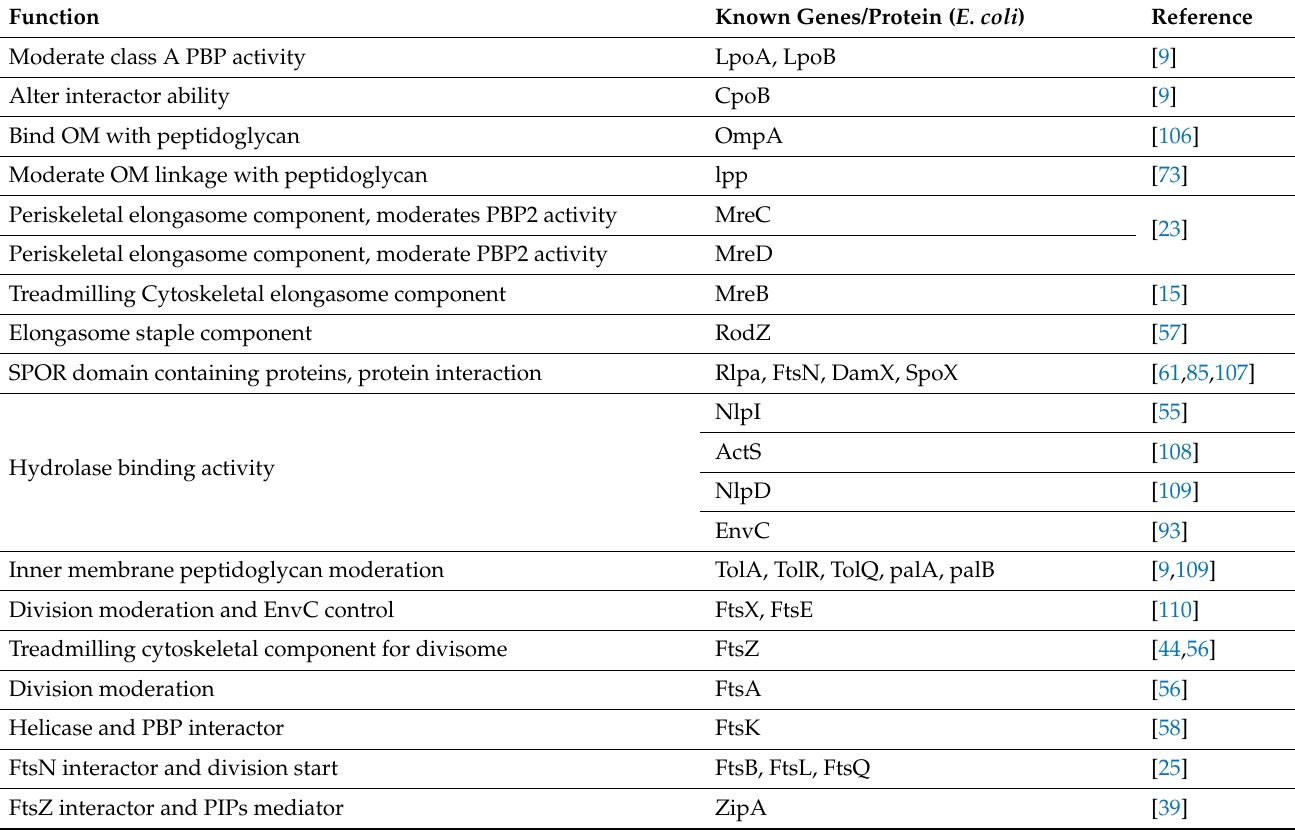
Table A3. Peptidoglycan associated and PBP regulatory